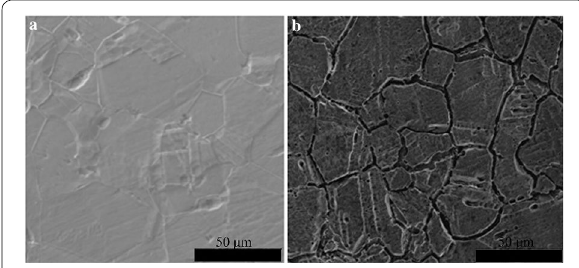
Figure 1 SEM microstructures of ( a ) as-received and ( b ) sensitized stainless steels after the measurements of DOS